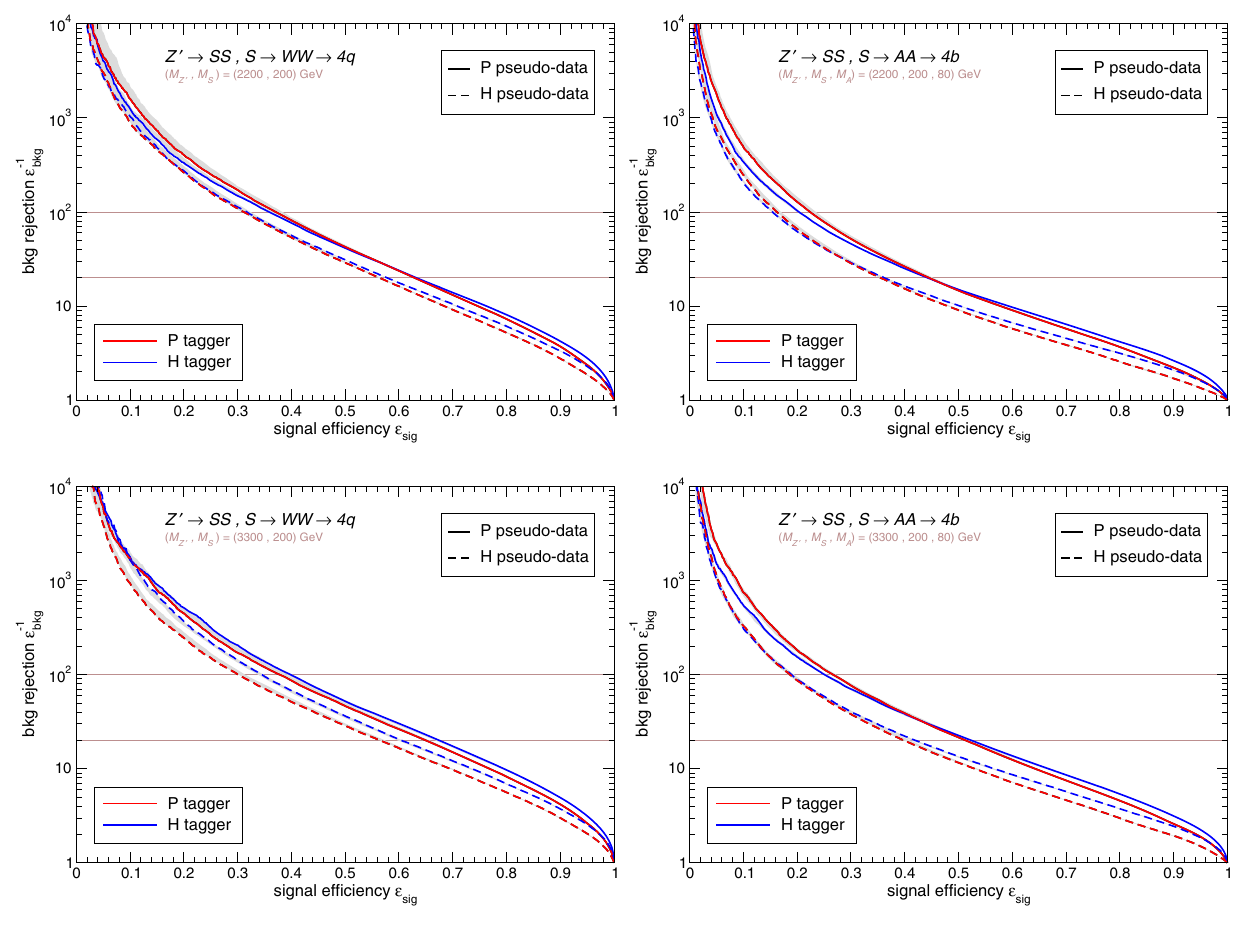
Fig. 6 ROC curves for 4P jets with m J ∼ 200 GeV